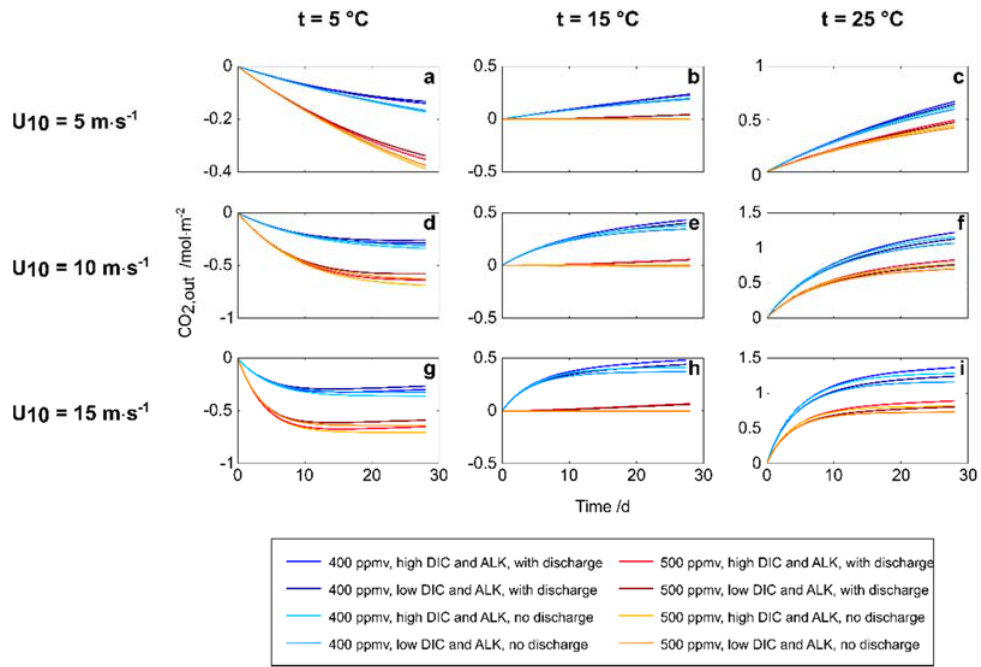
Figure 2. Sensitivity study of CO 2 outgassing. U 10 : wind speed in 10 m above the sea surface; t: temperature. Positive values represent outgassing of CO 2 from the ocean. DIC and TA in the low DIC and ALK scenario were 2.025 and 2.2 mol·m − 3 , respectively. Corresponding values of the high DIC and ALK scenario were 2.2 and 2.4 mol·m − 3 . In scenarios with discharge, 30 m³·h − 1 of AWL-derived water (pH T = 6.8) were discharged into the test area. This amount is produced by an AWL demonstration plant [27]. ( a – i ) Amount of outgassed CO 2 in dependence of different temperatures and wind speeds.